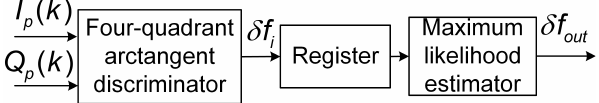
Figure 2. Block diagram of the frequency pulling algorithm.